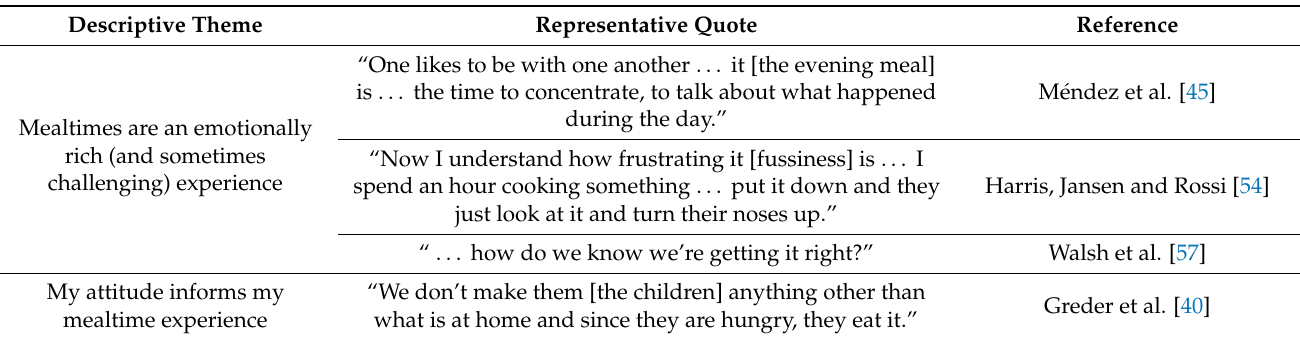
Table 5. Representative quotes for second analytical theme: attitudes and emotions of fathers during mealtimes.